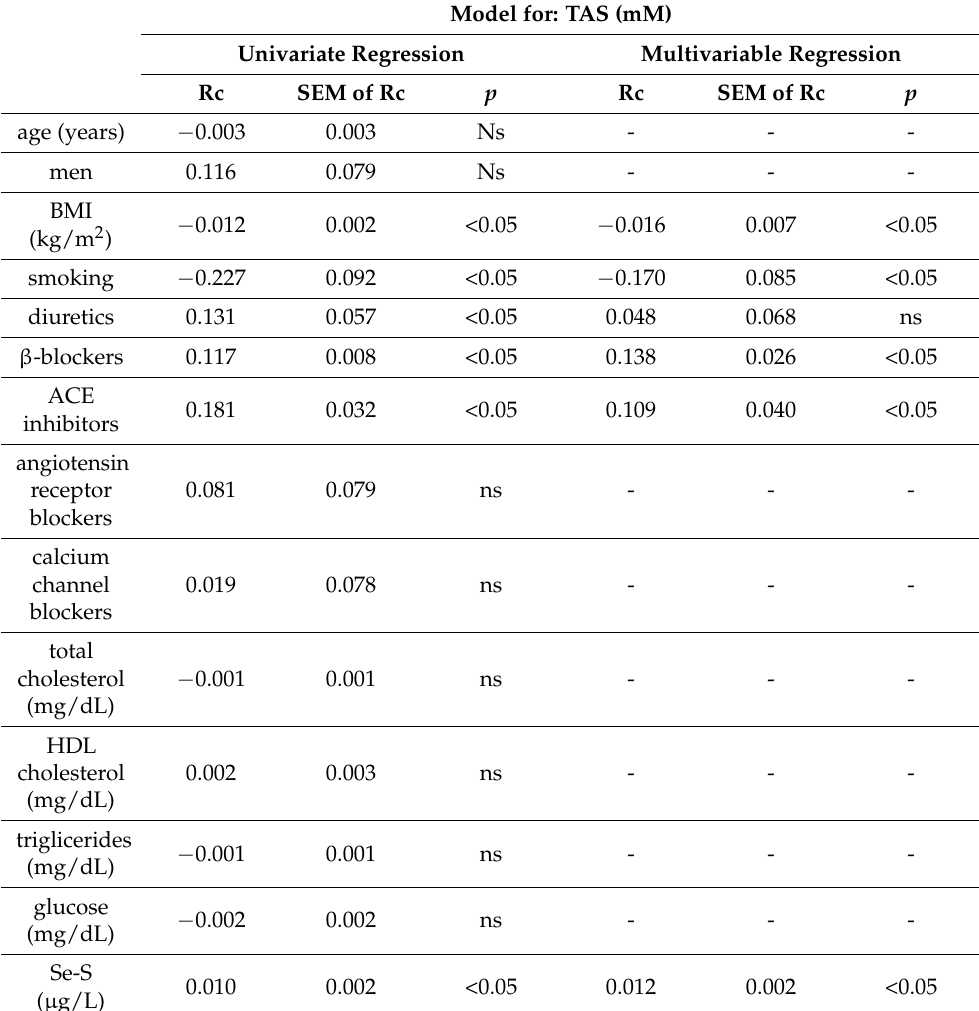
Table 4. Results of regression analysis in the studied group of patients with arterial hypertension: model estimation for the dependent variable TAS